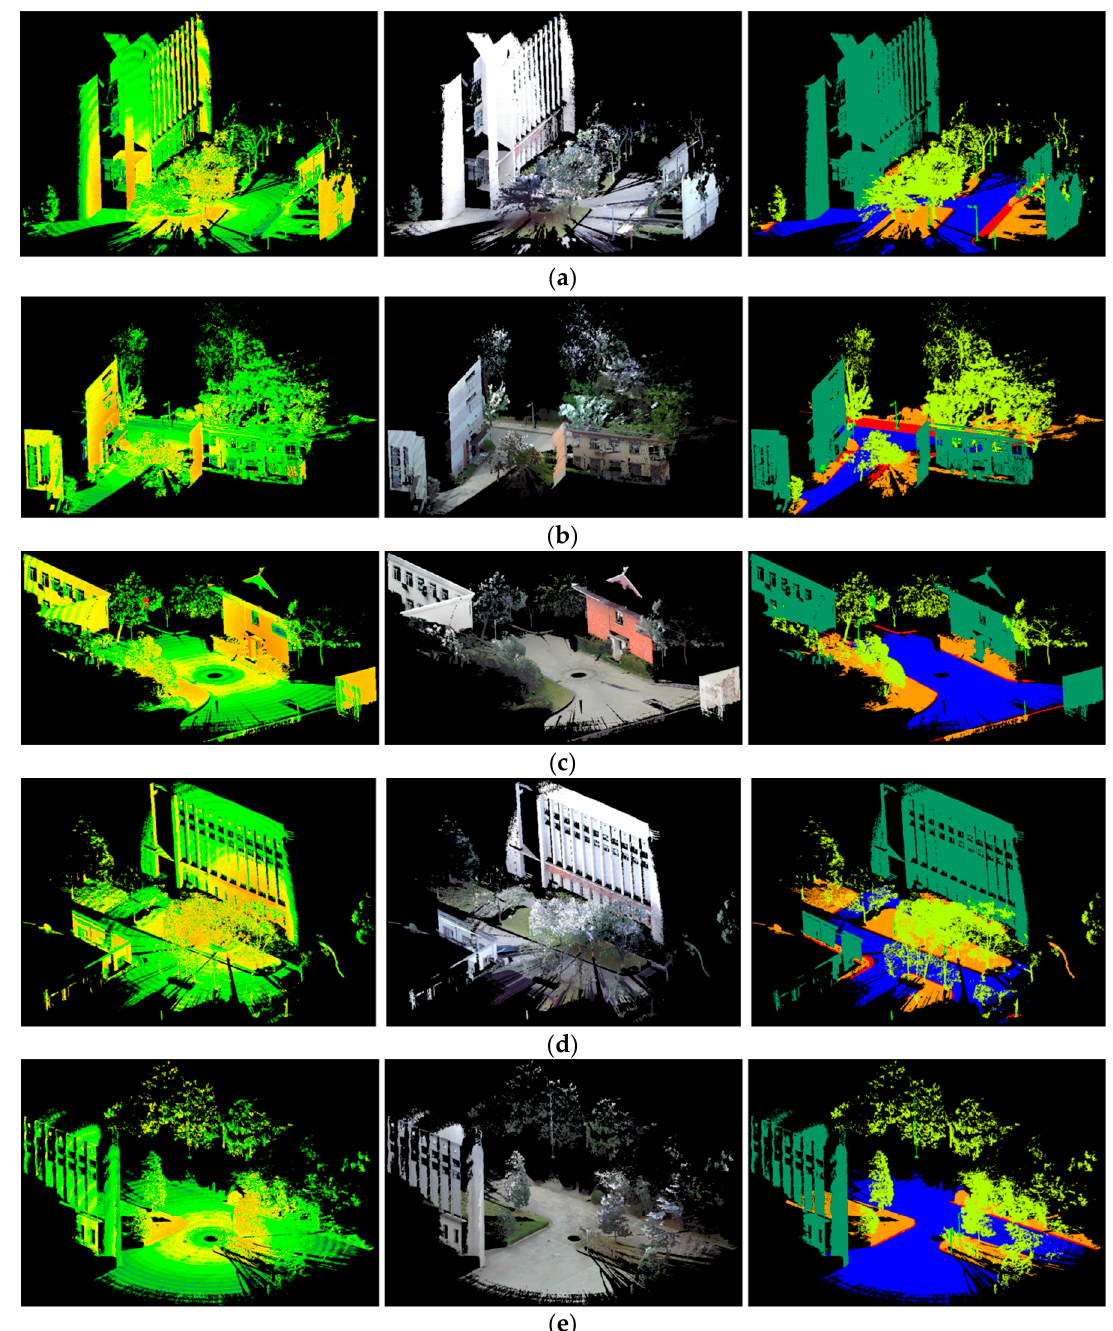
Figure 2. Intensity values (left), RGB colors (middle), and ground truth (right) for: ( a ) training set, ( b ) testing set 1, ( c ) testing case 2, ( d ) testing case 3, and ( e ) testing case 4. Legend for labels: ground façade pole tree vegetation curb.